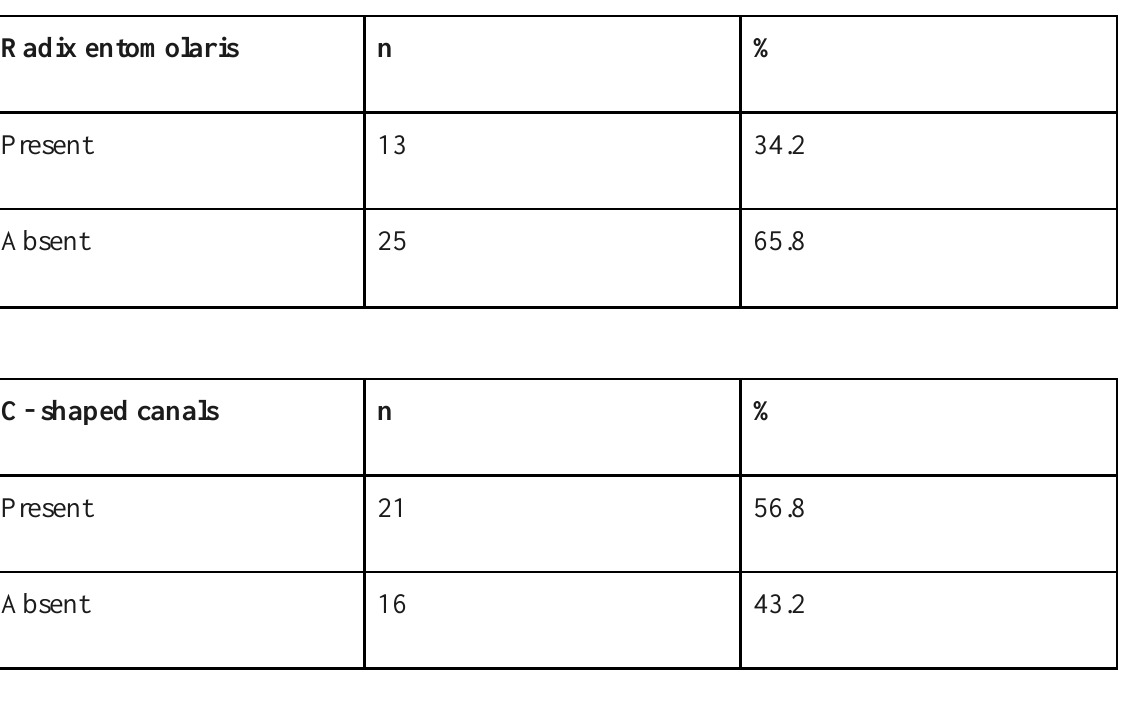
Prevalence of radix entomolaris in mandibular first molars (n=38) and C - shaped canals in mandibular second molars (n=37) examined in terms of